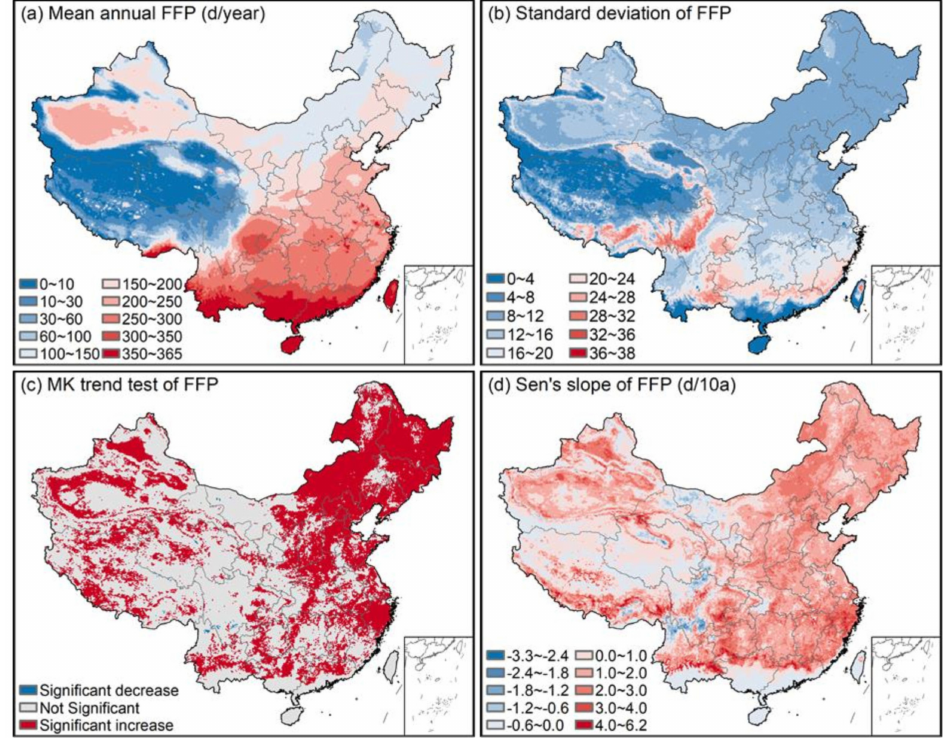
Figure 5. Spatial distribution of multi-year average FFP, ( a ) standard deviation of FFP, ( b ) trends of FFP based on the Mann–Kendall trend test ( c ) and Sen’s slope of FFP ( d ) across China during the